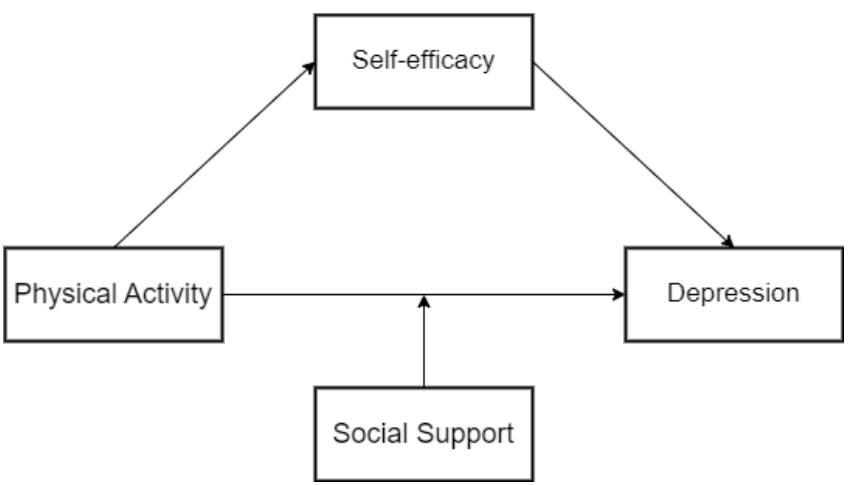
Figure 1. Hypothetical model of the relationship between physical activity and mental depression.